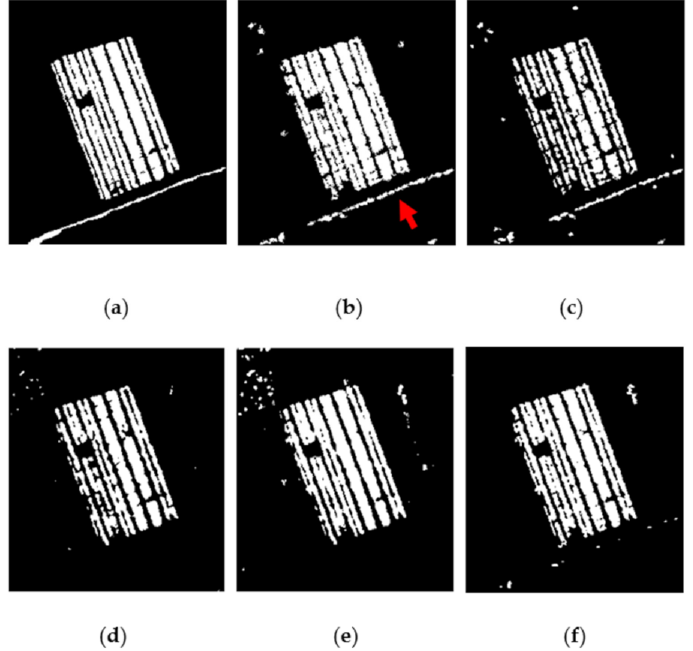
Figure 21. Change detection results on the Farmland D dataset. ( a ) Ground truth. ( b ) Result by Gabor-PCANet. ( c ) Result by NR-ELM. ( d ) Result by DBN. ( e ) Result by CNN. ( f ) Result by our proposed